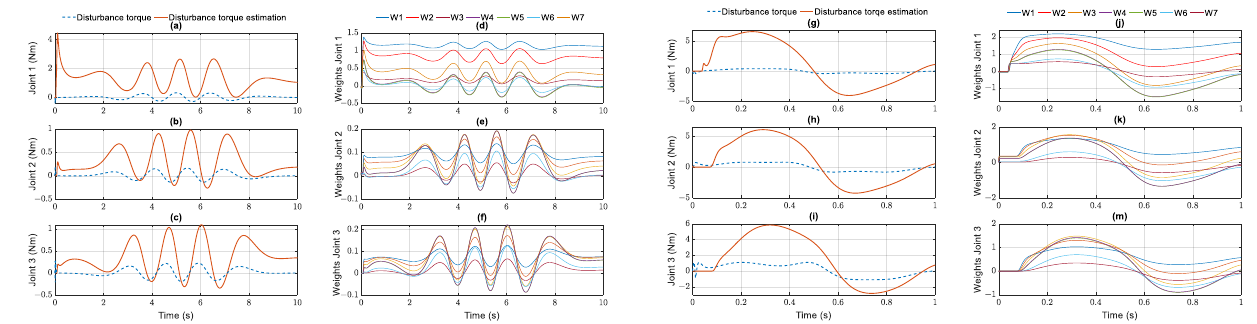
Figure 9. Disturbance torques estimation and weight update of joints from RBF NNs in the helix and in parabolic simulation: disturbance torque and disturbance torque estimation of ( a ) joint 1; ( b ) joint 2; ( c ) joint 3; weights update of ( d ) joint 1; ( e ) joint 2; ( f ) joint 3 in helix case; disturbance torque and disturbance torque estimation of ( g ) joint 1; ( h ) joint 2; ( i ) joint 3; weights update of ( j ) joint 1; ( k ) joint 2; ( m ) joint 3 in parabolic case. Table 6. RMSE Comparison among the controllers and PDAFS in the Helix simulation.